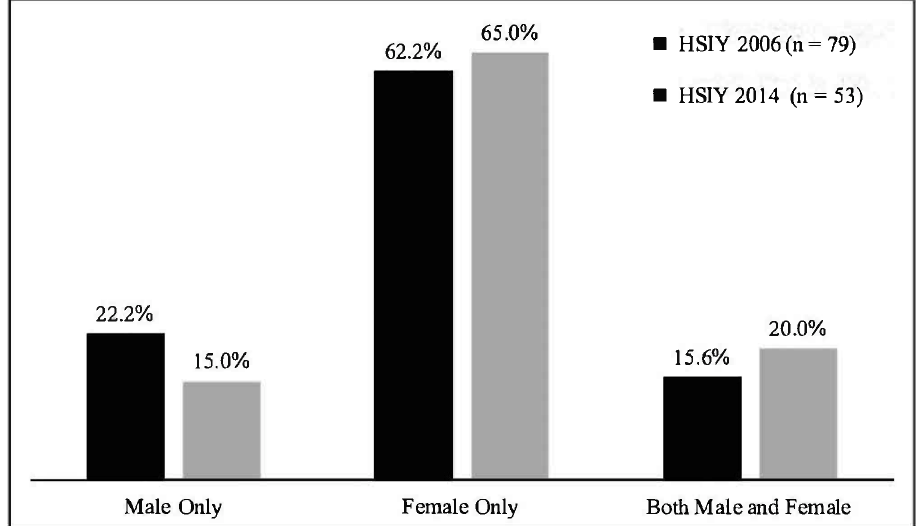
Figure 1. Genders of exploiters reported by sexually exploited